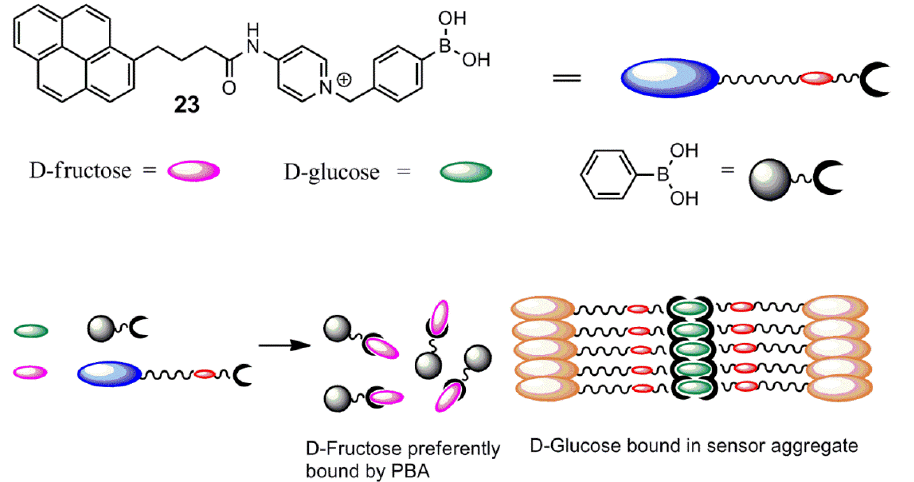
Figure 8. Cartoon representation of the different types of aggregates formed upon binding of glucose and fructose [68]. PBA, phenylboronic acid.